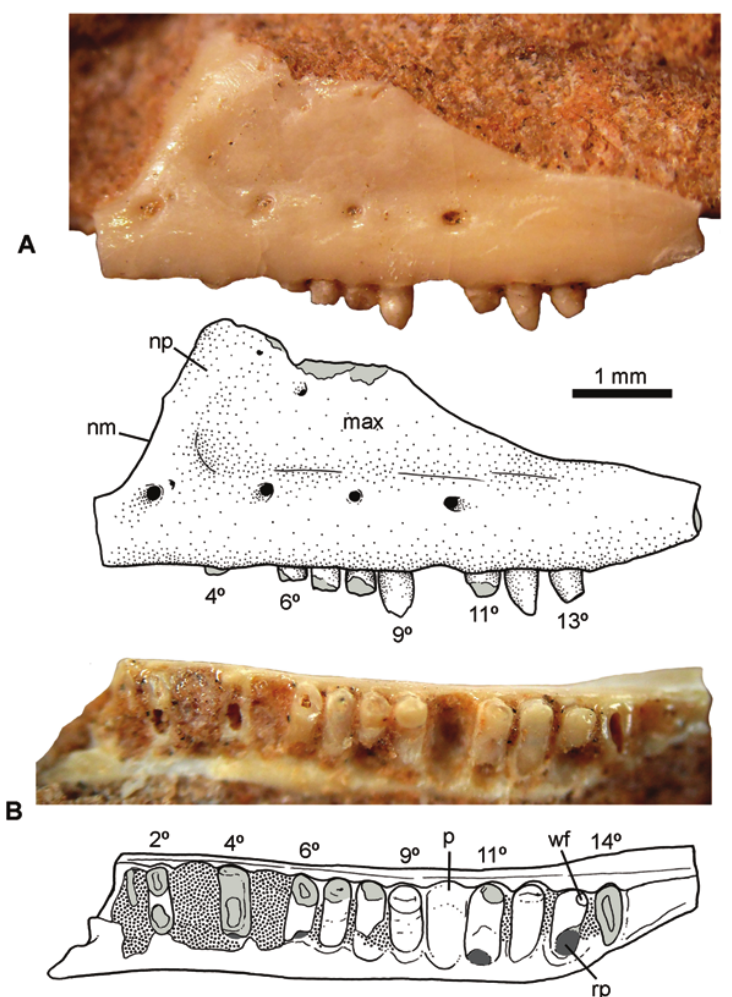
Fig. 2 – Brasiliguana prudentis gen. et sp. nov. Holotype MN 7230-V, left maxilla in lateral (A) and ventral (B) views with accompanying drawings. Light grey indicates broken bone and teeth. Dark grey indicates replacement pits. Regular dotted surfaces indicate main portions with sandstone. Abbreviations: max , maxilla; nm , narial margin; np , nasal process of the maxilla; p , pleura of the maxilla; rp , replacement pit; wf , wear facet. Numbers refer to teeth